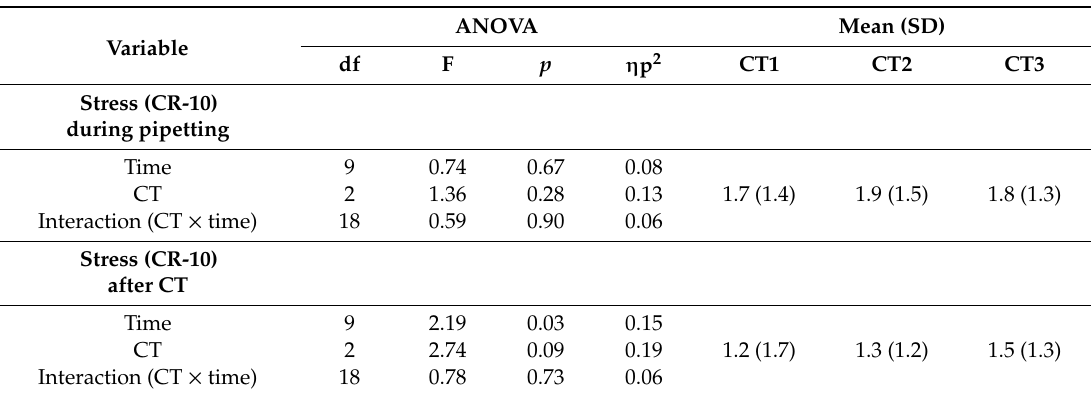
Table 1. Ratings of stress during the last minute of pipetting bouts and just after cognitive task (CT) bouts. Results of repeated measures ANOVAs with main e ff ect and interactions, and mean values (with SD) in each CT condition across all points in